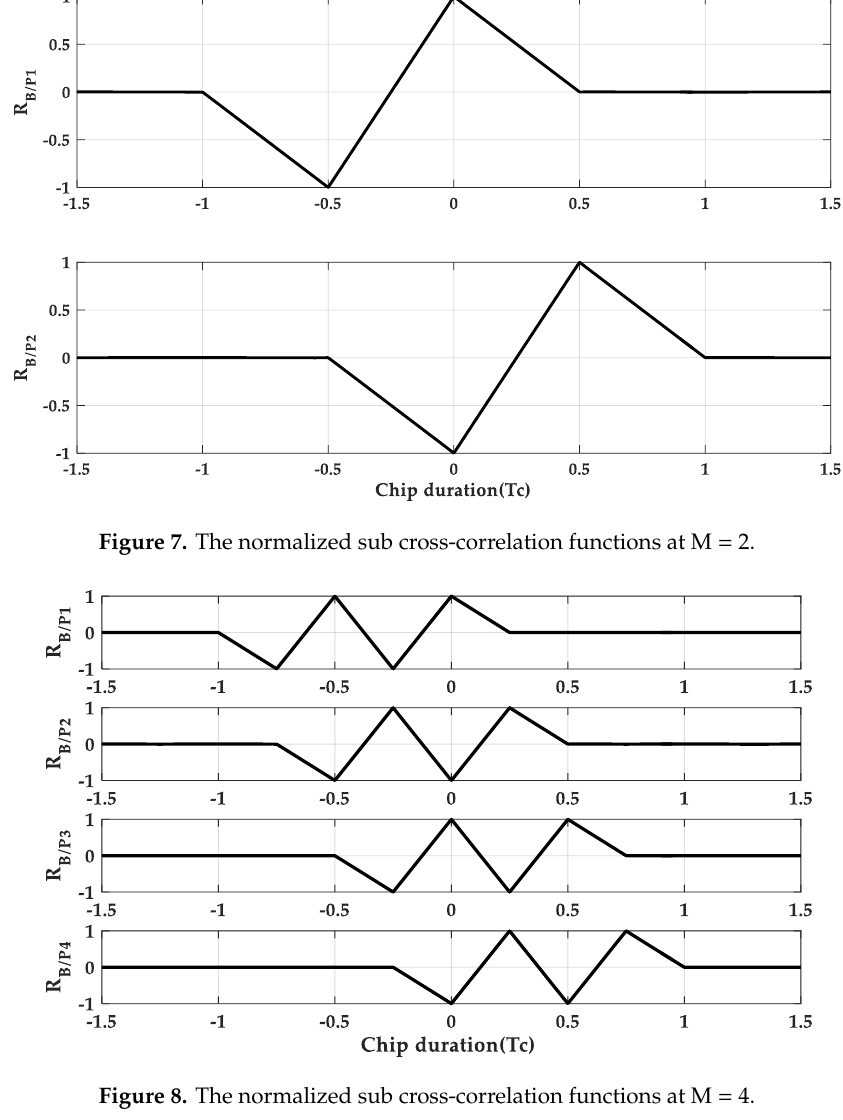
Figure 8. The normalized sub cross-correlation functions at M = 4.